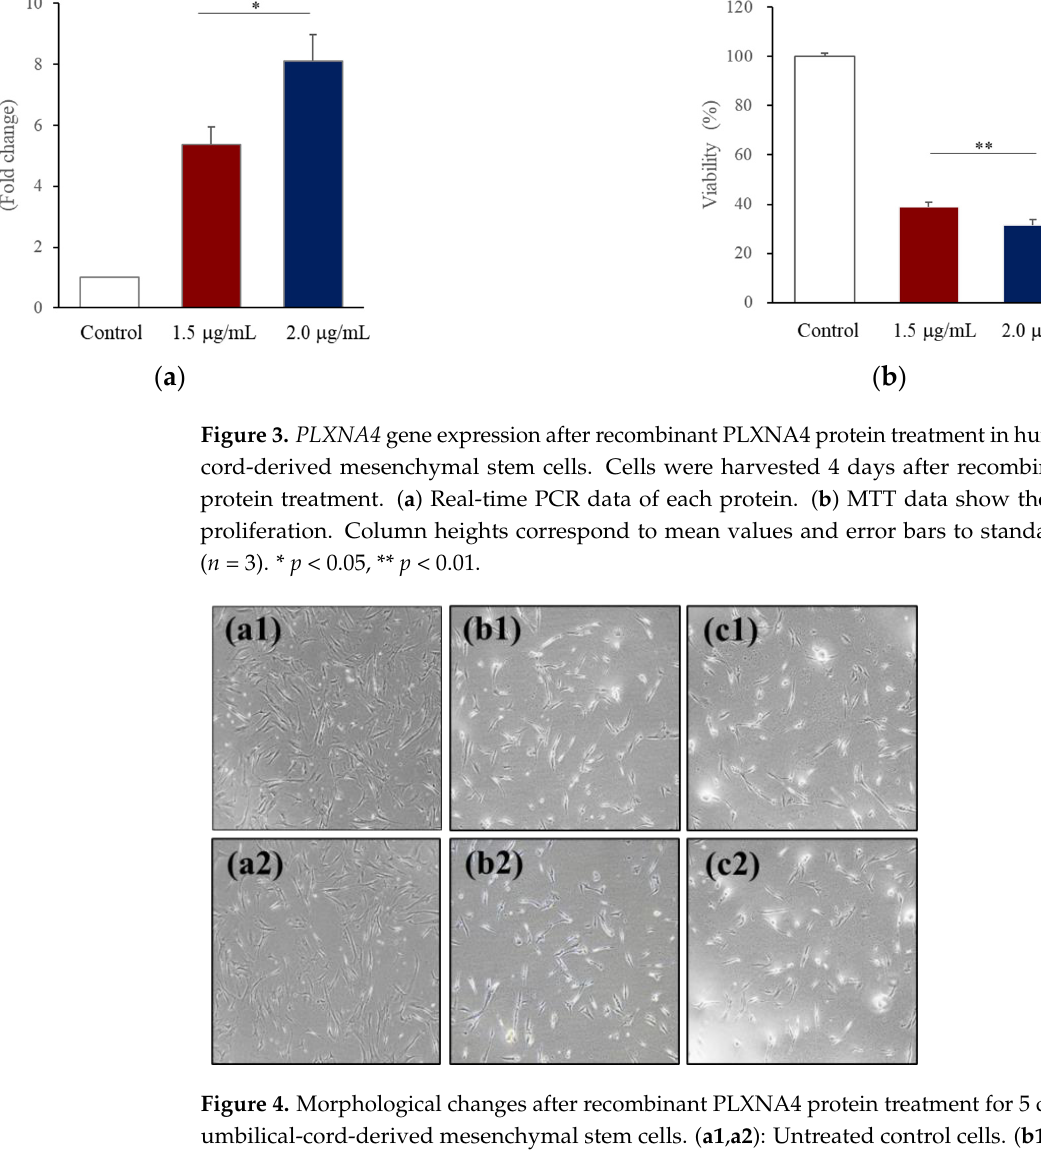
( b ) Figure 5. Expression of neuron-related proteins and genes in human umbilical-cord-derived mesenchymal stem cells after recombinant PLXNA4 protein treatment. Cells were harvested 5 days after 2 μ g/mL recombinant PLXNA4 protein treatment. ( a ) Fluorescence images of each protein. Original magnification 200×. ( b ) Fold expression of each gene using real-time polymerase chain reaction analysis. MAP2: Microtubule-associated protein 2. NEUROD1: Neuronal Differentiation 1, NF-L: Neurofilament-L, MBP: Myelin basic protein, Column heights correspond to mean values and error bars to standard deviations ( n = 3). * p < 0.05, ** p < 0.01 .